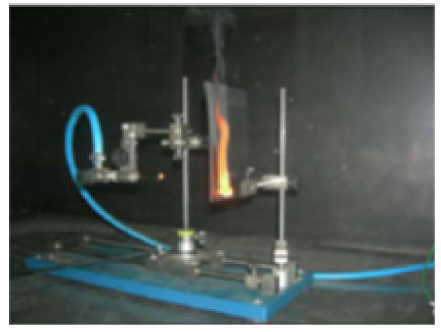
Figure 7. The UL-94 needle flame test set up.